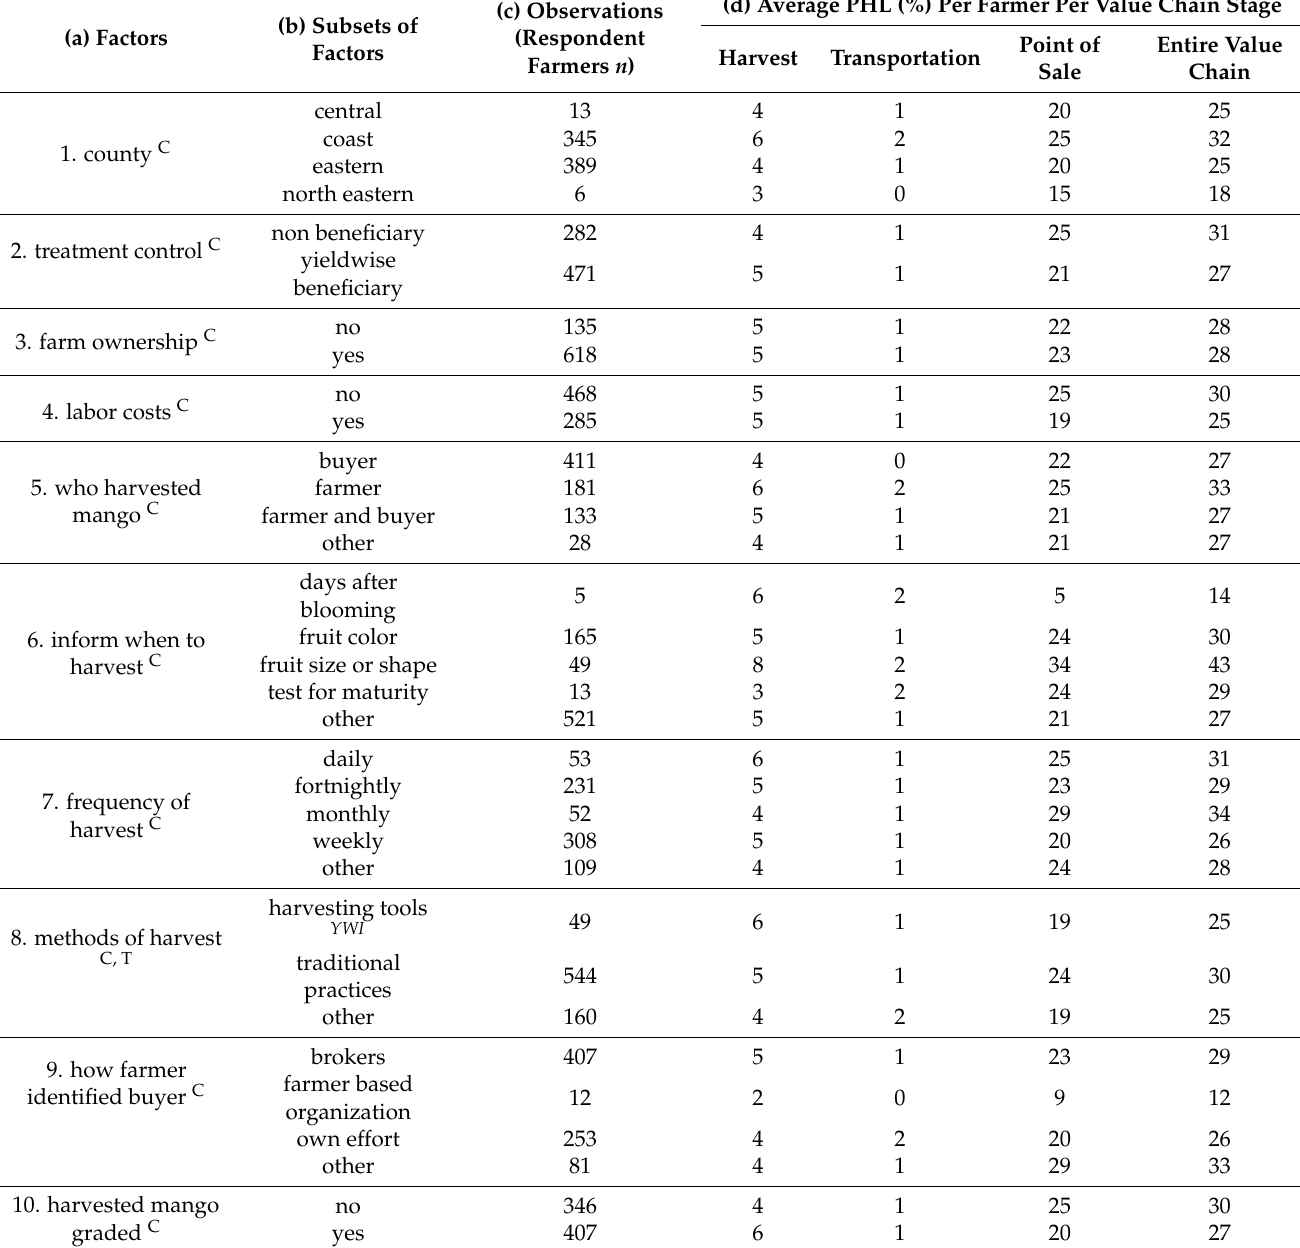
Table 4. Summary of all factors, subsets of factors, respondent farmers, and the seven types of mango PHL: Column (a) lists all 21 factors including the 19 categorical C , two numerical N , and four containing postharvest technologies T . Column (b) expands each factor into subsets that were previously referred to as subset descriptors in Table 1. The superscript YWI is used to identify technologies promoted by the YWI. “Other” refers to the combination of multiple subsets as reported by respondent farmers. Column (c) indicates the number of respondent farmers belonging to each subset. Column (d) encompasses mango PHL at harvest, during transportation, at point of sale, and as a total of all three value chain stages. PHL averages cannot be categorized by numerical factors, hence the n/a